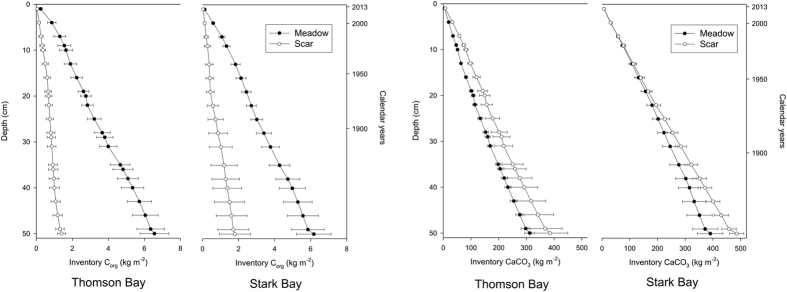
Mean ± SEM inventory of organic carbon (Corg) and calcium carbonate (CaCO3) in sediments from seagrass meadows and mooring-induced scars at Thomson Bay and Stark Bay.Calendar years only refers to cores from seagrass meadows across both sites, based on 210Pb age-models.